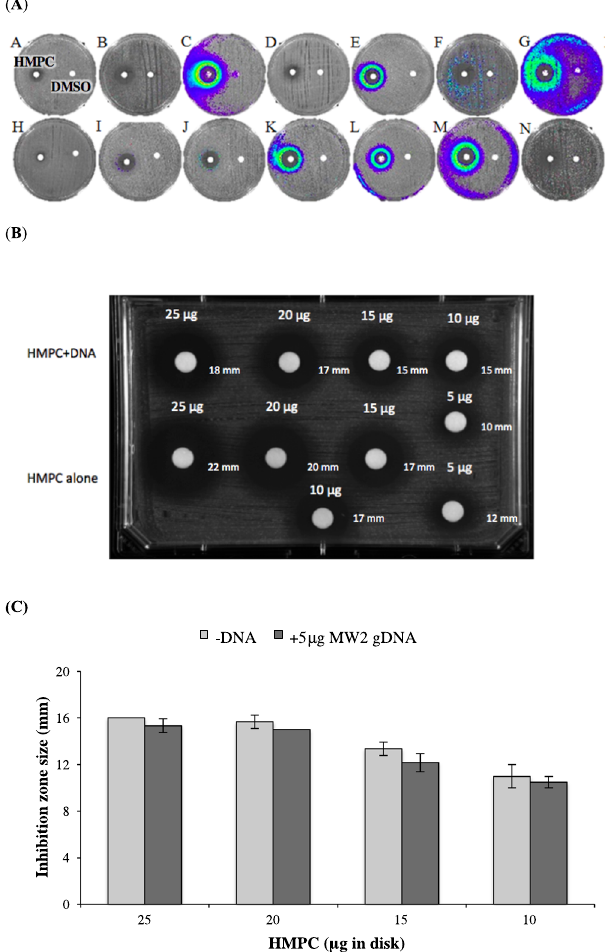
Figure 3. Response of the S. aureus promoter- lux array to HMPC treatment. ( A ) Results of promoter- lux array screening. The name of each reporter clone is shown in the upper left corner of each picture. A clear zone around the disc indicates inhibition of growth in the presence of higher concentrations of HMPC. At the periphery of the inhibition zone, where sub-MIC levels of HMPC are present, changes in luminescence indicate altered transcription. The disc on the left is HMPC and on the right of each panel is a DMSO (vehicle) control. ( B ) Zones of S. aureus growth inhibition produced by HMPC in the presence or absence of calf thymus DNA. Decreasing quantities of HMPC (25–5 μ g) were incubated with either 5 μ g calf thymus DNA or TE buffer (control) before being spotted onto discs and placed onto agar plates containing S. aureus MW2 bacterial lawns. ( C ) Disc diffusion assay with varying concentrations of HMPC in the absence or presence of S. aureus genomic DNA. HMPC was incubated without or with 5 μ g of S. aureus genomic DNA and was then applied to a filter paper disc and placed onto a TSA plate containing S. aureus MW2 bacteria in a soft agar overlay. After overnight incubation at 37 °C, zones of inhibition were measured with a ruler. Bars show mean values + / − standard deviation of three independent assays, and no differences are statistically